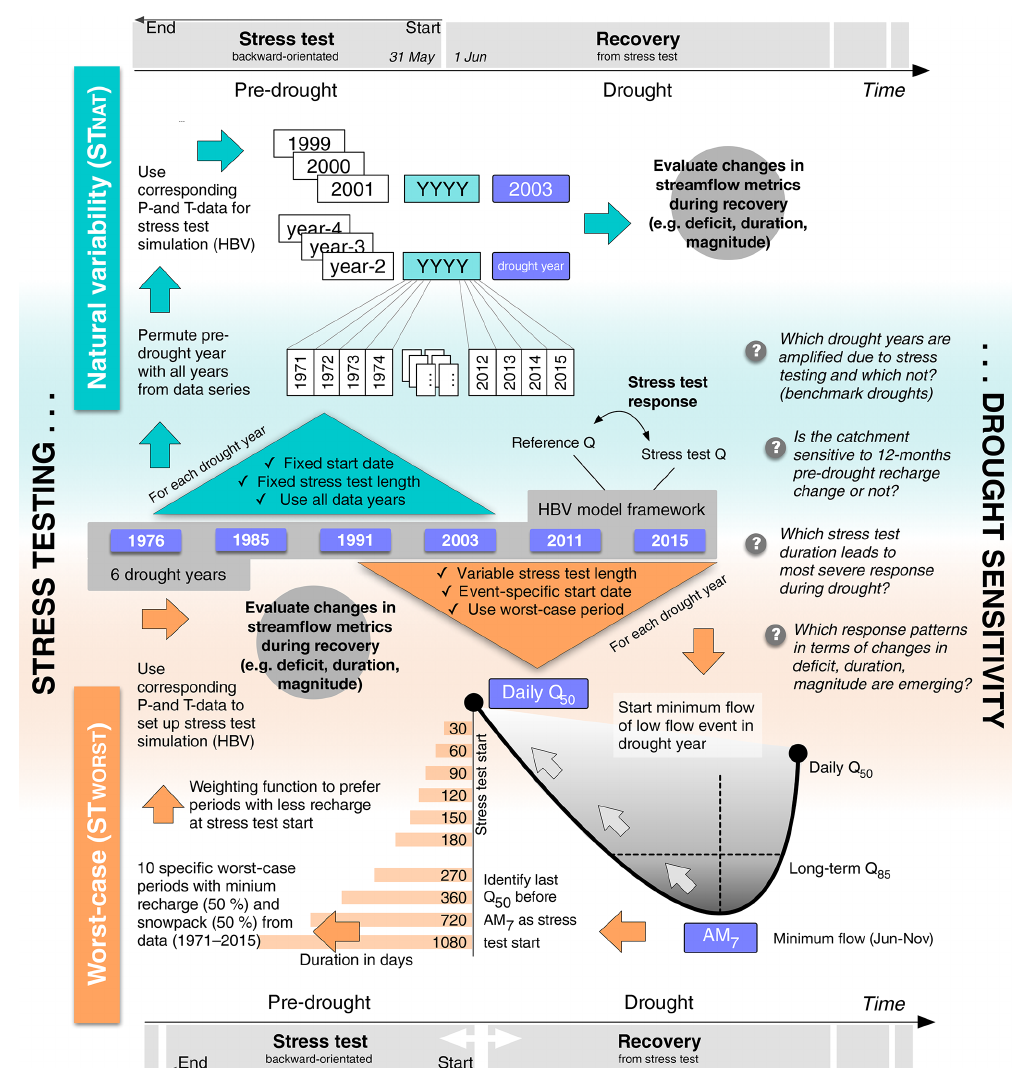
Figure 1. Overview of general stress testing approach, research questions and the procedures for stress tests ST NAT and ST WORST